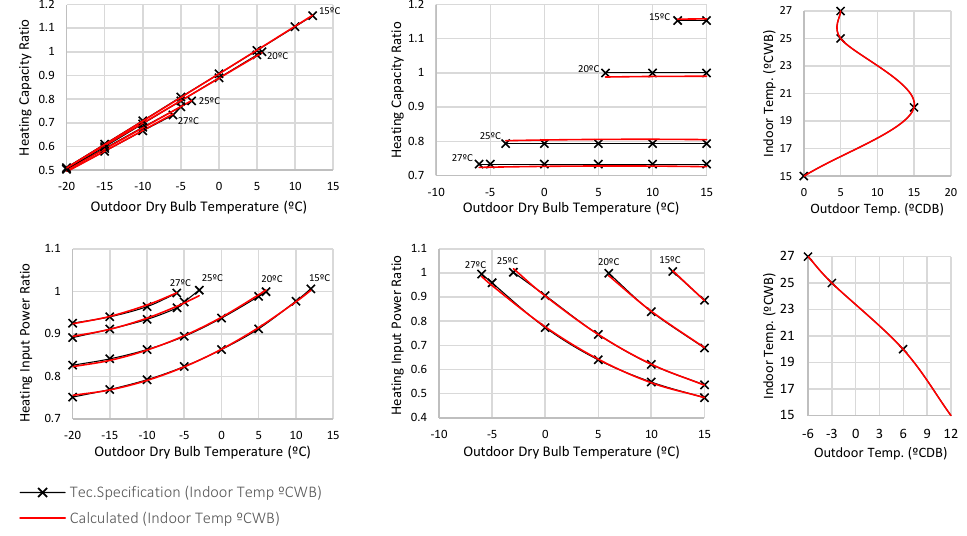
Figure A5. VRV system performance curve comparison, Technical specification displayed in black and calculated “z” value in red for heating, and blue for cooling. For cooling, the MixedUse HP unit calculated capacity curves have a CV(RMSE) of 0.93% with an R2 of 99.4%, while its electric input has a CV(RMSE) 7.07% with an R2 of 94.5%. For heating, the calculated curve has a CV(RMSE) of 0.15% with an R2 above 99%. Its COP curve has a CV(RMSE) of 0.19% with an R2 above 99%; see Figure A6.